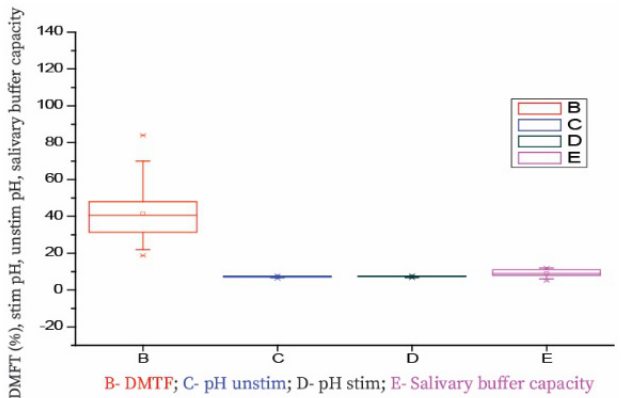
Figure 11. Box-chart representation of the four parameters.